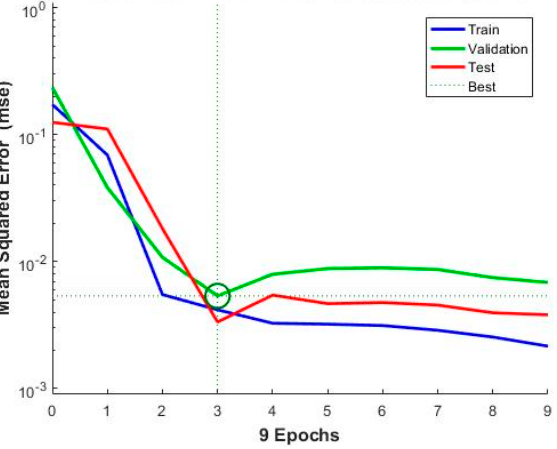
Figure 3. Plot of mean squared error (MSE) values after each iteration during training.